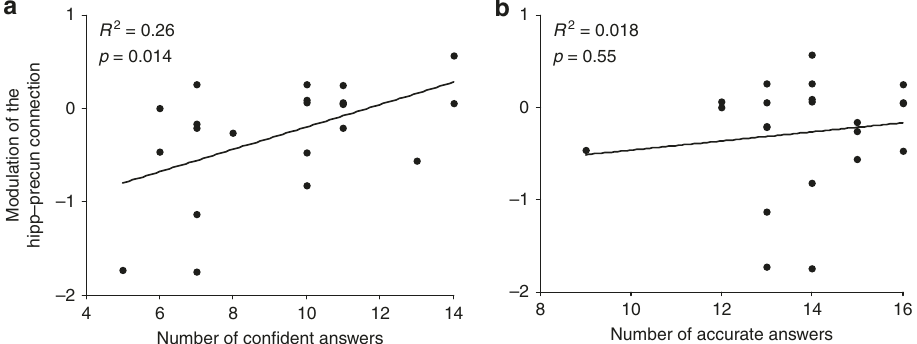
Fig. 5 Correlation between DCM parameter and behaviour data. Correlation between the DCM parameter of the modulation of the effective connectivity from the hippocampus to the precuneus and ( a ) the number of con fi dent answers, ( b ) the number of accurate answers derived from news recall